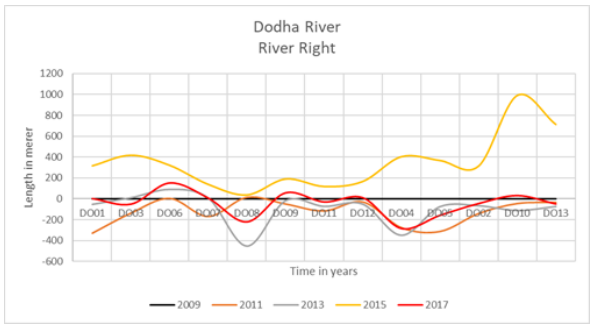
Fig 10 : Variation in shifting of righ t bank of Dodha River inwards and outwards taken 0 as the